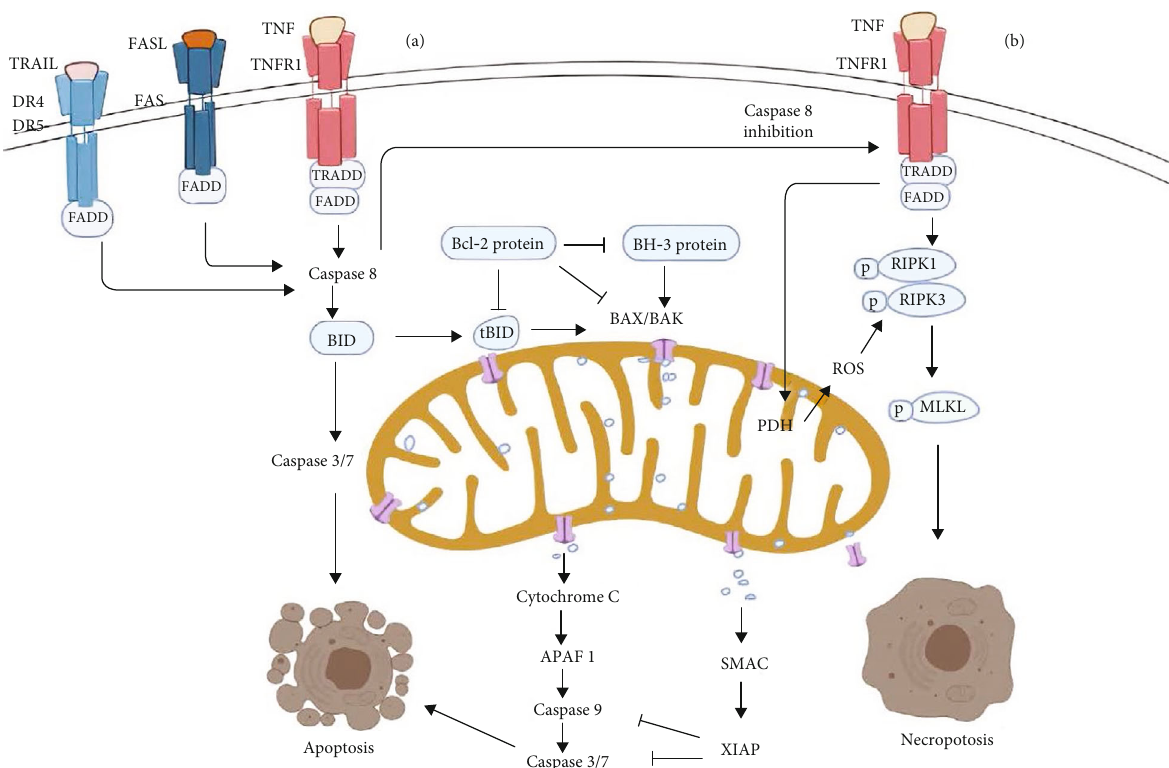
Figure 2: Mechanisms of mitochondrial regulation of apoptosis and necroptosis. Apoptosis proceeds mainly through the extrinsic and the intrinsic pathway. The TNFR superfamily (e.g., FAS, TNFR1, or DR4/DR5) is activated and interacts with death receptor ligands, FASL, TNF, or TRAIL. For example, TNF binds to and activates TNFR, recruiting the adaptor molecule FADD. Together, these proteins activate caspase 8, which cleaves and stimulates downstream caspase 3 and 7, which target hundreds of cellular components leading to rapid cell apoptosis. The pathway of mitochondrial-dependent apoptosis is instigated by intrinsic stimuli (including oxidative damage, DNA damage, growth factor depletion, or Ca 2+ overload), which cause activation of BH3-only proteins. BH3-only proteins activate the e ff ector proapoptotic proteins BAX and BAK, resulting in MOMP. Then, MOMP leads to the release of mitochondrial intermembrane space proteins, including cytochrome c. Cytochrome c interacts with APAF1, generating a special set of proteins called the apoptosome. The apoptosome interacts with caspase 9, which stimulates caspases 3 and 7. MOMP contributes to the release of cytochrome and SMAC. SMAC blocks the E3 ubiquitin-protein ligase XIAP (an inhibitor of caspases 3/7), promoting apoptosis. (b) After death receptor activation, the function of caspase 8 determines whether the cell undergoes apoptosis or necroptosis. If caspase 8 activation is inhibited, TNF signaling induces the activation of RIPK1 and RIPK3. RIPK3 phosphorylates and binds to MLKL causing the generation of necrosomes. The necrosome can be shuttled to the mitochondrial membrane and cause mitochondrial membrane permeabilization via a di ff erent mechanism of apoptosis. The necrosome also activates the mitochondrial pyruvate dehydrogenase (PDH) complex, enhancing aerobic respiration and ROS generation. In turn, ROS can increase the activation of RIPK3 and promote necrosome